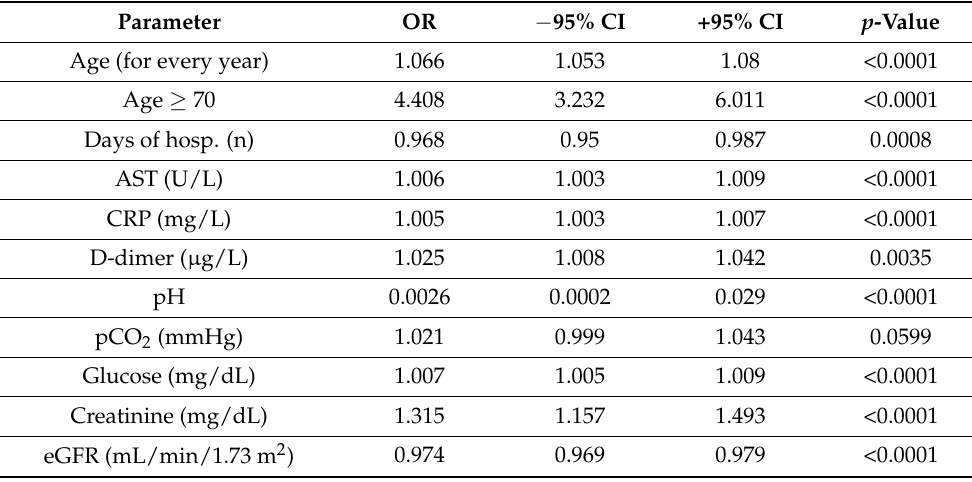
Table 4. Univariate predictors of in-hospital mortality of patients with